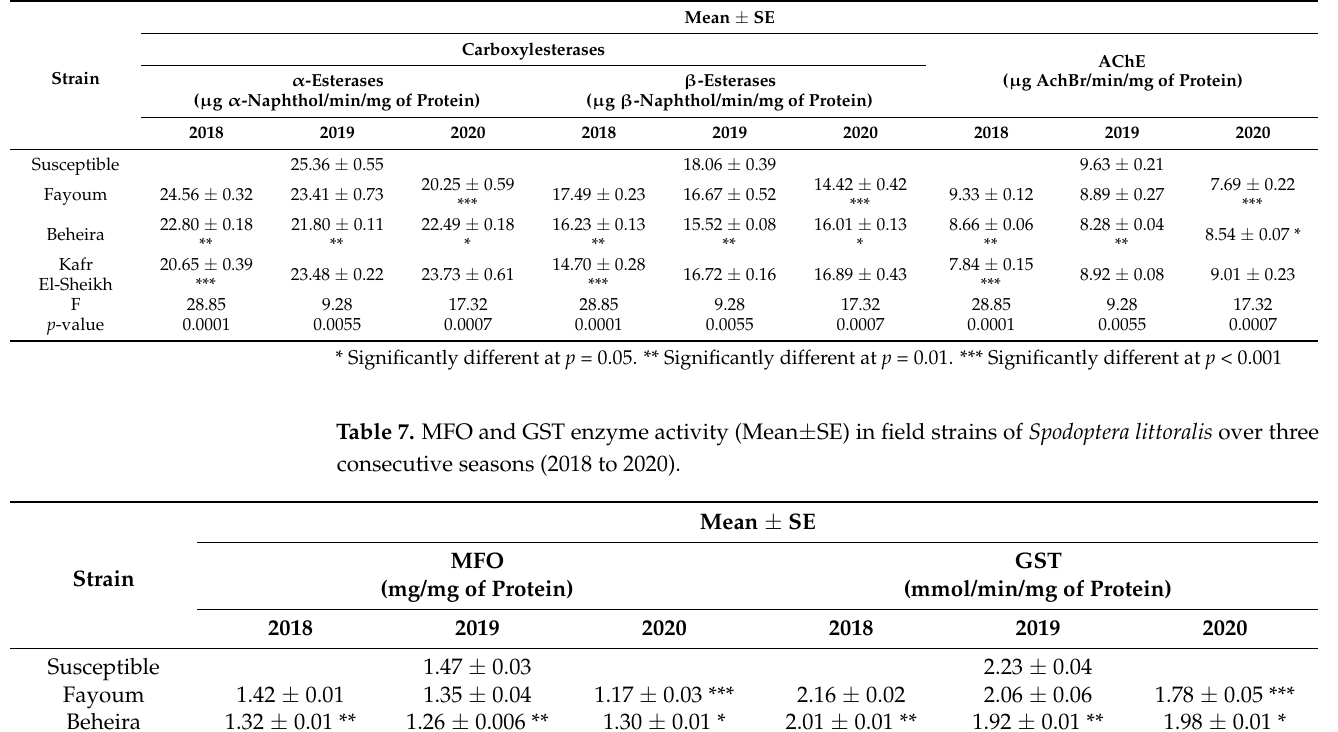
Table 6. Carboxylesterases and AChE enzyme activity (mean ± SE) in field strains of Spodoptera littoralis over three consecutive seasons (2018 to 2020).